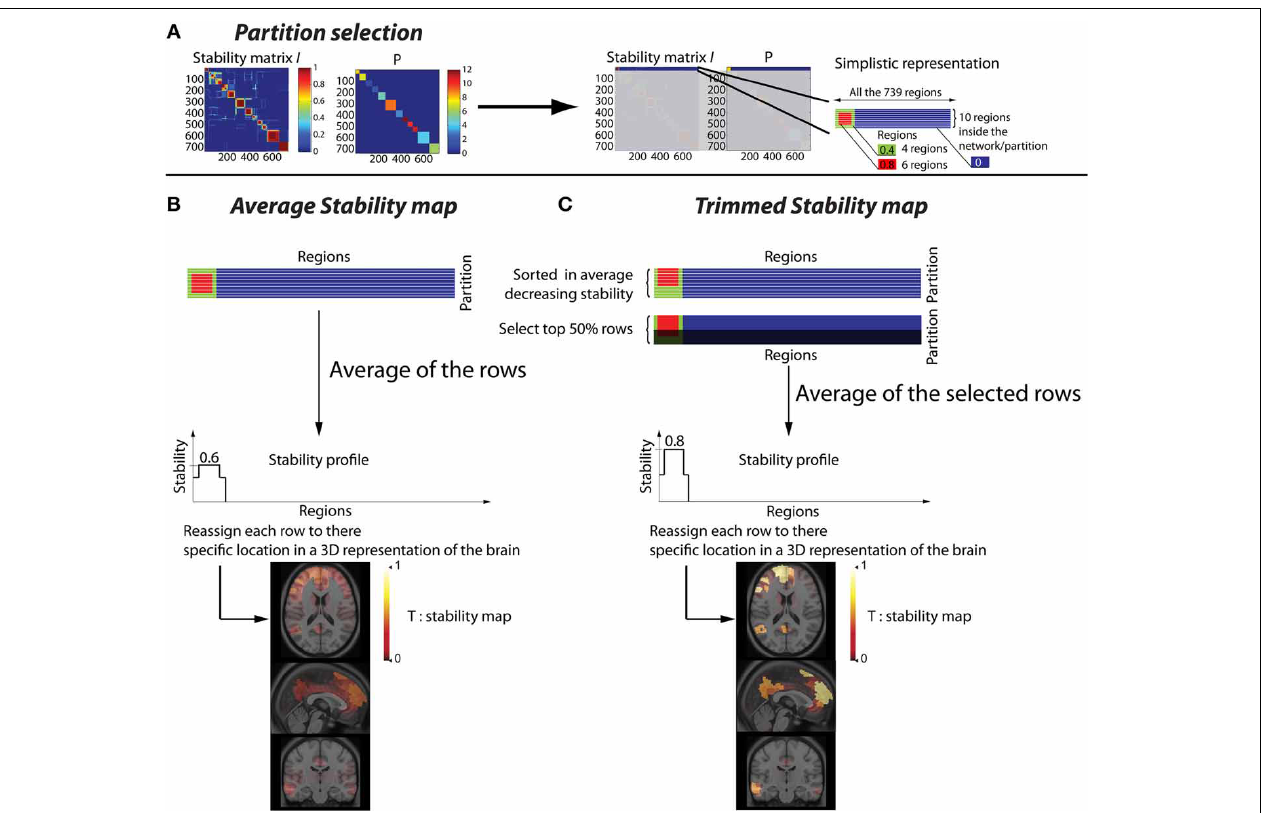
map obtained by averaging all the rows inside a network partition, resulting in a diffuse and low contrast representation of the network. (C) Trimmed stability map obtained by averaging the 50% rows showing the largest stability values, resulting in a representation of the network with greater